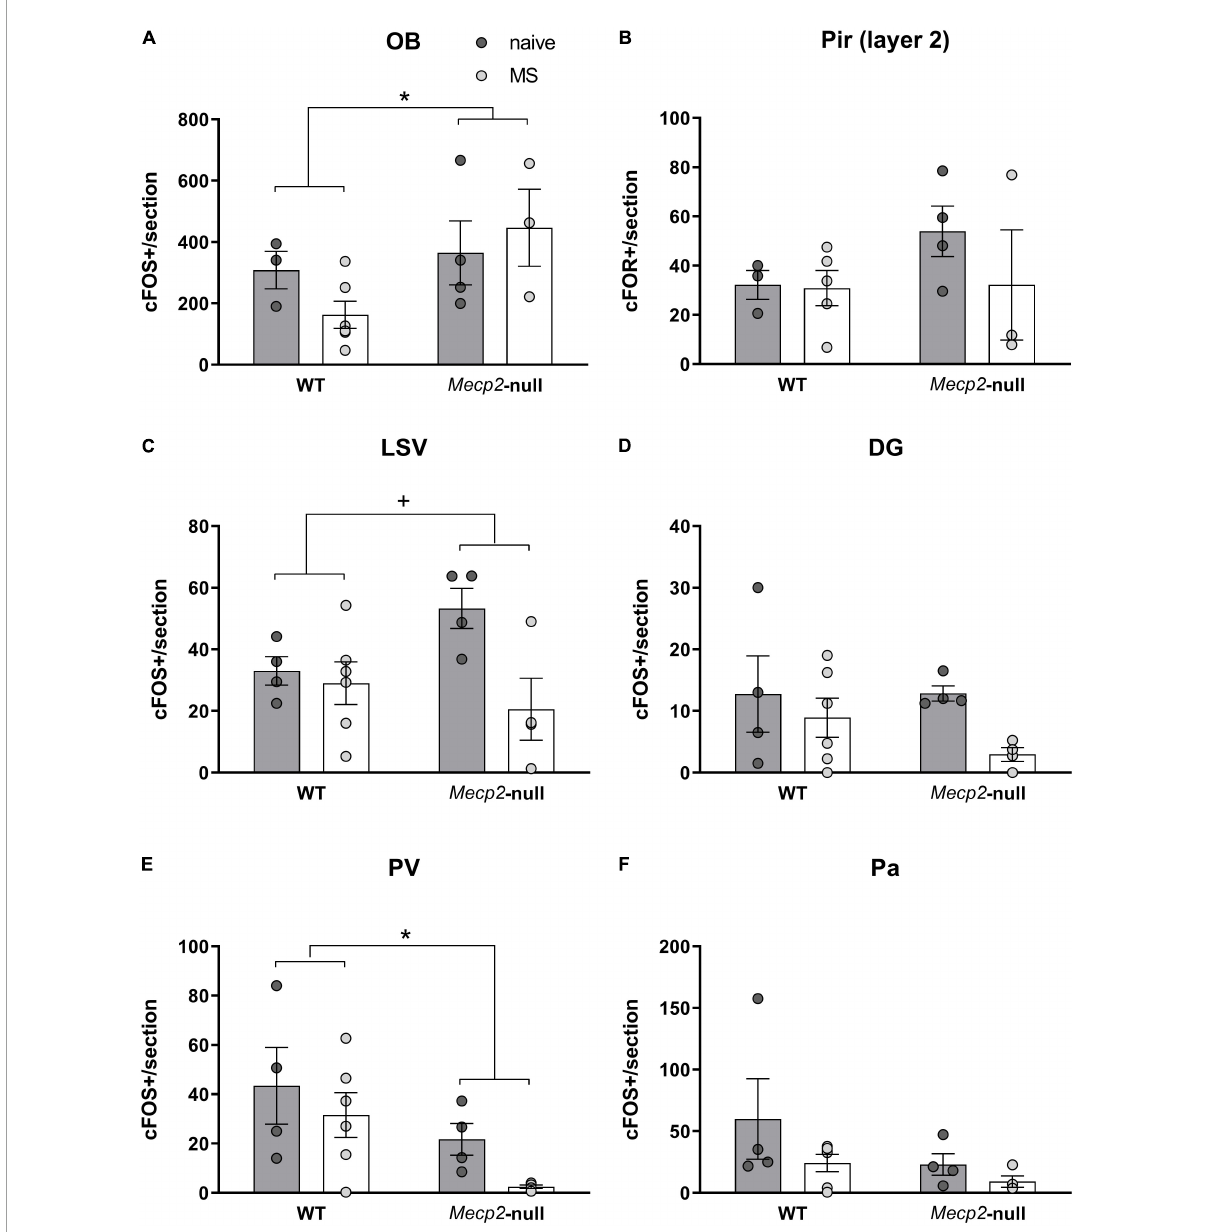
FIGURE4 c-FOS-ir at multiple brain areas is dependent on Mecp2 dosage and MS. Number of c-FOS positive cells per section at the (A) OB, (B) layer 2 of the Pir, (C) LSV, (D) DG of the hippocampus, (E) PV, and (F) Pa. All graphics describe individual values and mean ± SEM. * p < 0.05 by genotype; + p < 0.05 by group. DG, dentate gyrus of the hippocampus; OB, olfactory bulb; PA, paraventricular hypothalamic nucleus; PV, paraventricular thalamic nucleus; Pir, piriform cortex; LSV, ventral part of the lateral